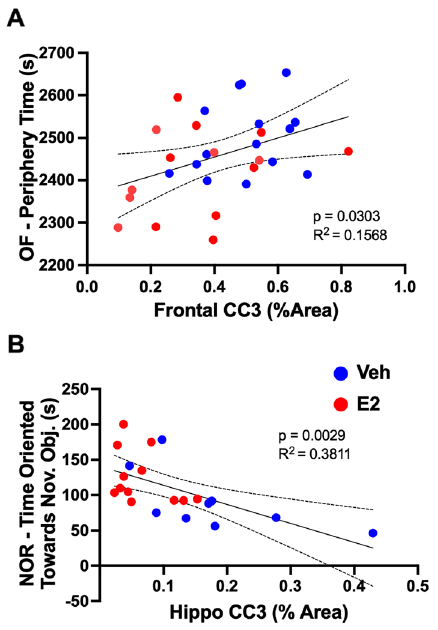
Figure 4. Cleaved caspase-3 (CC3) variability explains delirium-like behaviors. ( A ) Regression analysis across groups (n = 21–30) demonstrates a statistically significant positive relationship between frontal cortex cleaved caspase-3 (CC3) and time spent in the periphery during an open field test (OF). ( B ) Regression analysis reveals a significant negative relationship between hippocampal CC3 and time oriented towards a novel object during a novel object recognition test (NOR). Veh = vehicle treated; E2 = 17β-estradiol treated. Dotted lines represent 95% confidence